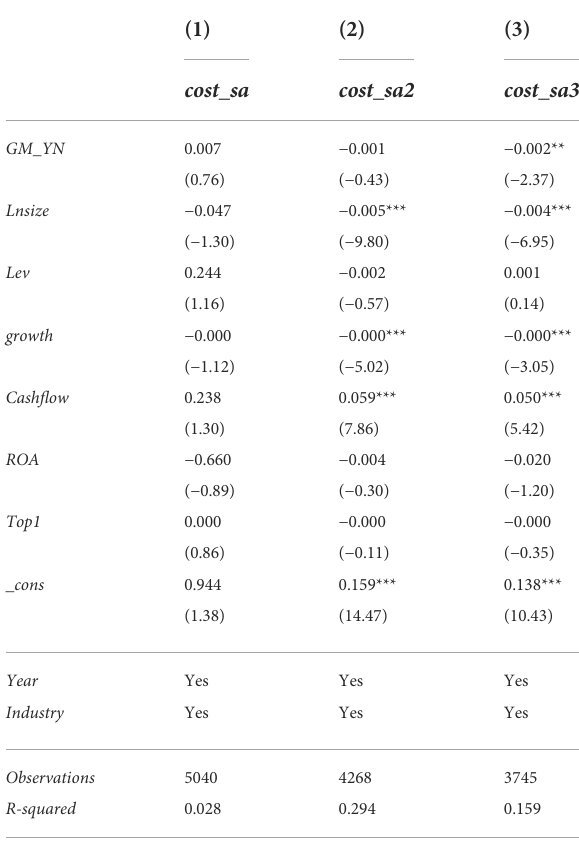
TABLE 8 Cost motivation test. TABLE 9 Descriptive statistics for M&A performance.